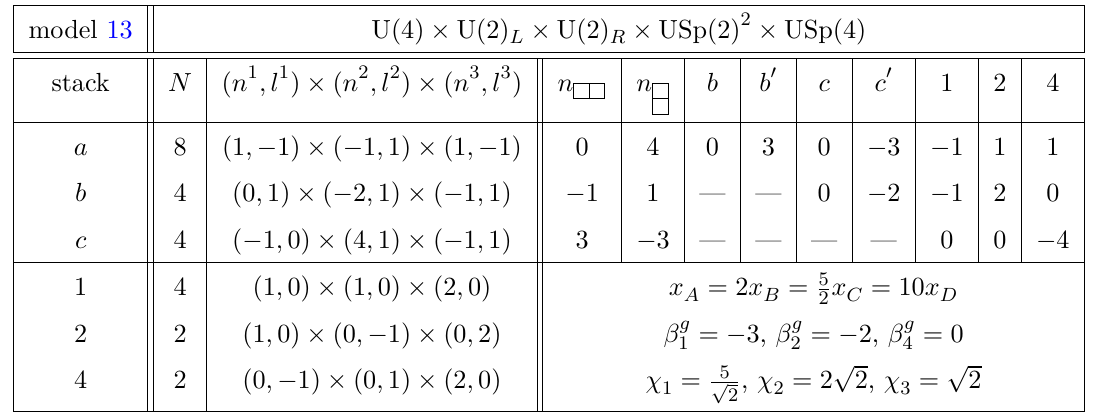
Table 13 . D6-brane configurations and intersection numbers of Model 13, and its MSSM gauge